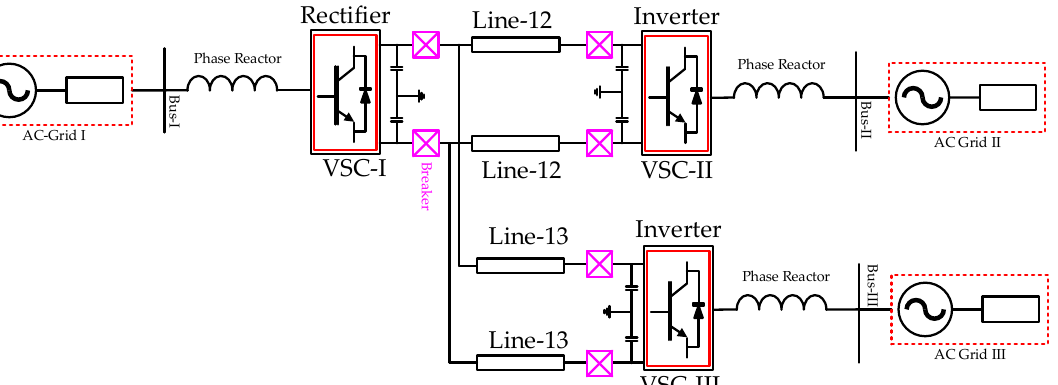
Energies 2019 , 12 , x Figure 10. Three-terminal VSC-HVDC system. Figure 10. Three-terminal VSC-HVDC system. Figure 10. Three-terminal VSC-HVDC system.